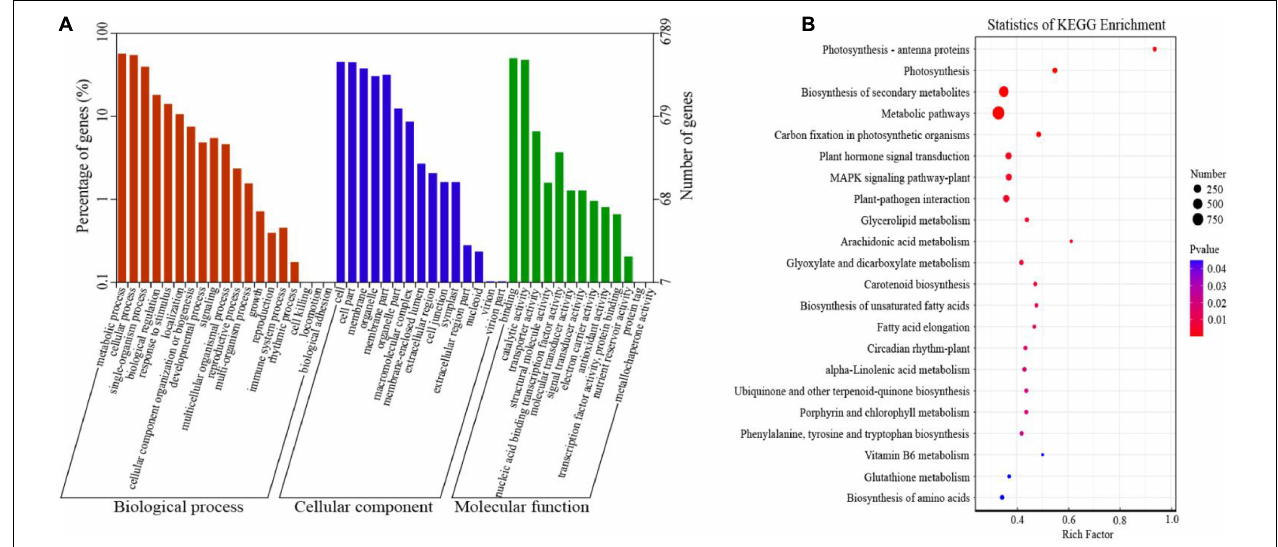
FIGURE 3 | Functional annotations of differentially expressed genes (DEGs) in cold-stressed pepper leaves. (A) Gene ontology (GO) classification of DEGs. (B) Kyoto Encyclopedia of Genes and Genomes (KEGG) pathway enrichment and bubble